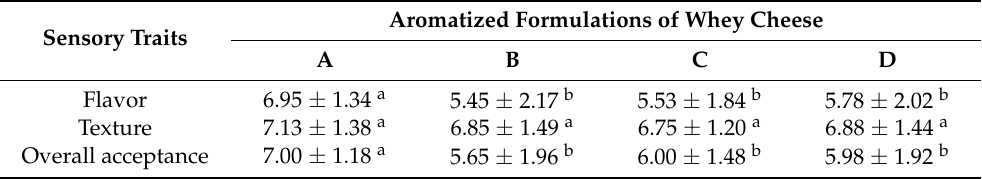
Table 2. Aromatized whey cheese sensory results (average ± standard deviation).